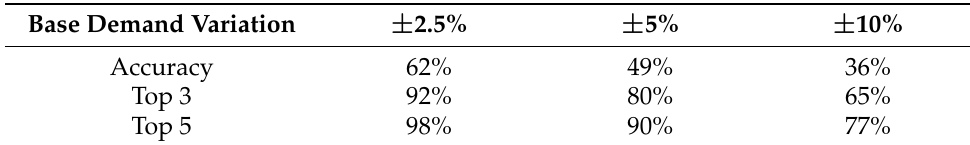
Table 3. Influence of base demand variation on model accuracy for the Net3 network with an emitter coefficient range of 10–15 with 500,000 inputs.